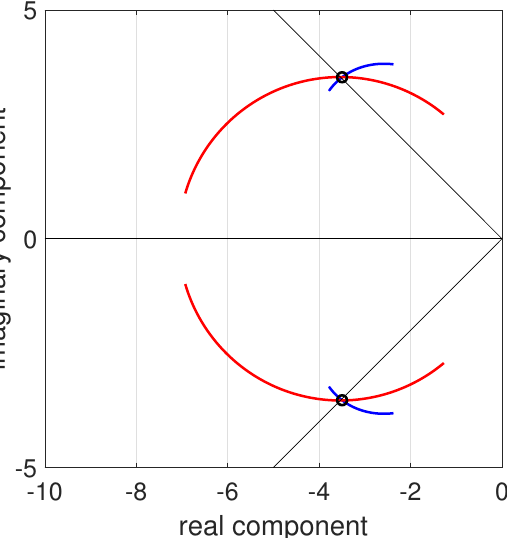
Figure 9. Root loci of the simplified characteristic Equation (40) in function of λ : PD root locus (red line), FPD root locus (blue line), allocated poles p 1,2 (circle) and the locus of poles with damping